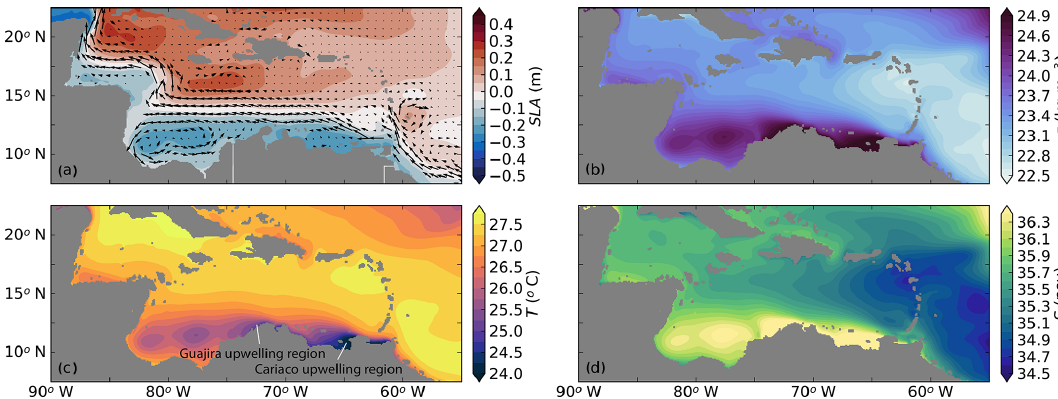
Figure 3. The 20-year near-surface average properties of the Caribbean Sea in Ekman100. (a) Mean sea-level anomaly (SLA) in meters with velocity vectors. Surface current vectors are only shown every eighth grid cell for clarity purposes. (b) Density ( σ = ρ − 1000; kgm − 3 ), (c) temperature ( ◦ C), and (d) salinity (psu). Properties in panels (b, c, d) are averages over the upper 50m.